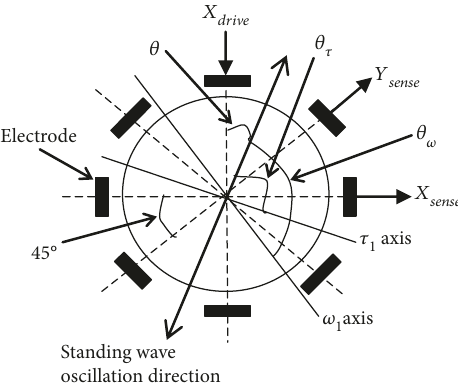
Figure 1: The ring resonator parameters and the standing wave position in the di ff erential CVG.